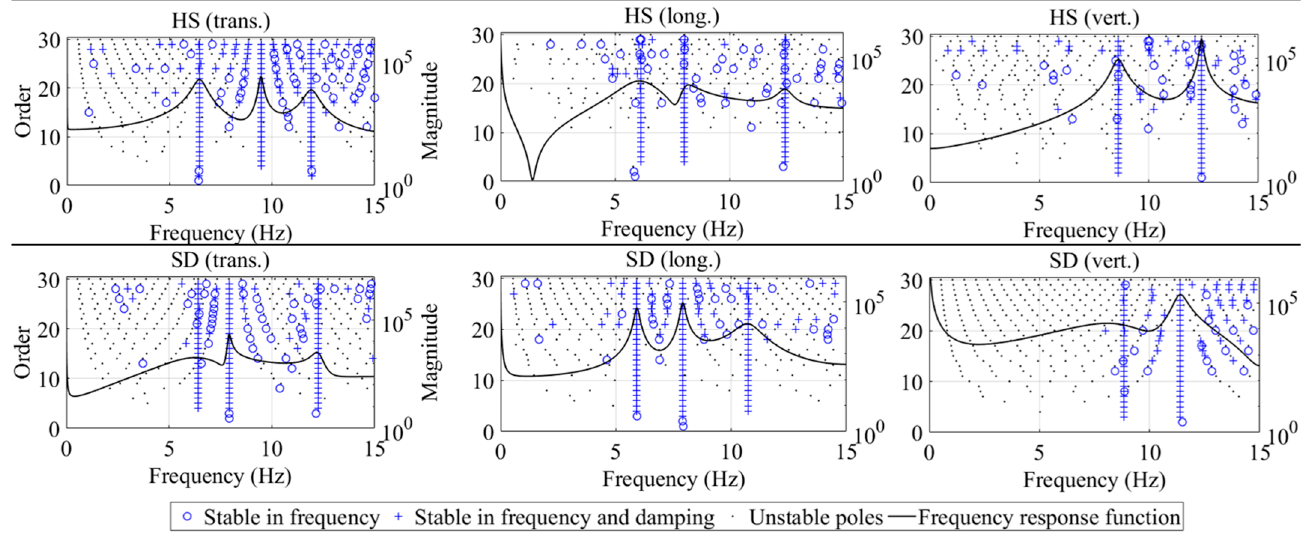
Figure 11. Stabilization plots from output ‐ only SSI ‐ COV method measured for building dynamic modal properties in three directions.